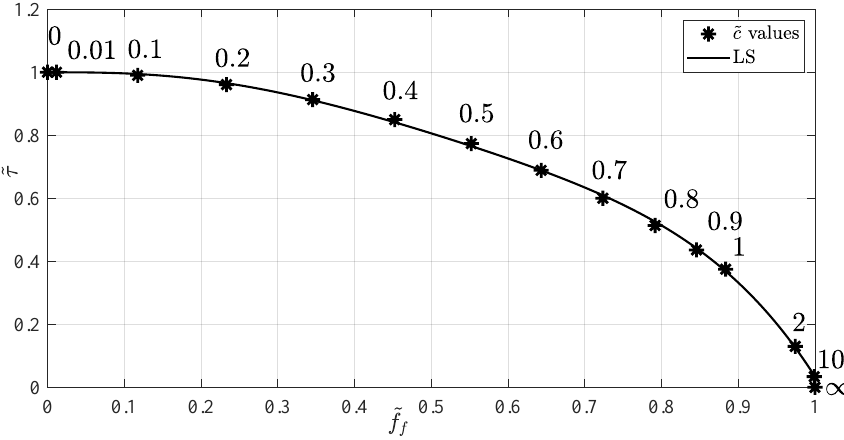
Figure 7. Normalized LS with the corresponding values of ˜ c